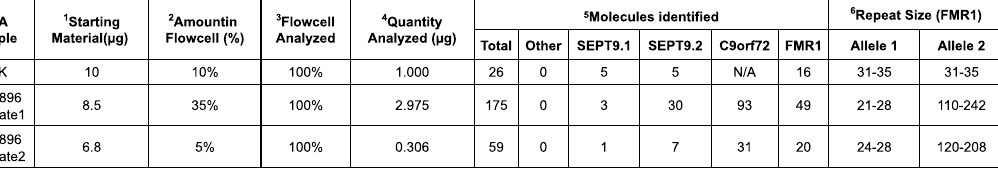
Fig. 6 Analysis of repeat length and methylation status of the FMR1 locus. a Histograms of the distribution of CGG repeat length for FMR1 on two DNA samples (HEK DNA, and the clinical sample, NA06896). The n represents the number of molecules identi fi ed in three categories, normal (<50 repeats), pre-mutation (50 to 200 repeats) and full-mutation (>200 repeats). b Cytosine methylation analysis of the CpG island located within the FMR1 promotor region of DNA sample NA06896. All CpG or non-CpG sites are represented on the X axis (the list and position of sites are in Supplementary Table 1). Molecules are ordered by repeat size and grouped by mutation status (normal, pre-mutation, full-mutation). Line graphs represent the frequency of molecules identi fi ed as methylated for a speci fi c CpG or non-CpG site within this population. c The table summarizing the libraries prepared and the results obtained from these samples. (1) Amount of DNA used to prepare the library. (2) Amount of starting material injected in the fl ow cell. (3) Proportion of the fl ow cell analyzed. (4) Relative quantity of starting material analyzed. (5) Number of molecules analyzed on the MT platform and repartition according to the oligonucleotide binding pattern. (6) Quanti fi cation of FMR1 repeat size, N/A: Not included in the library